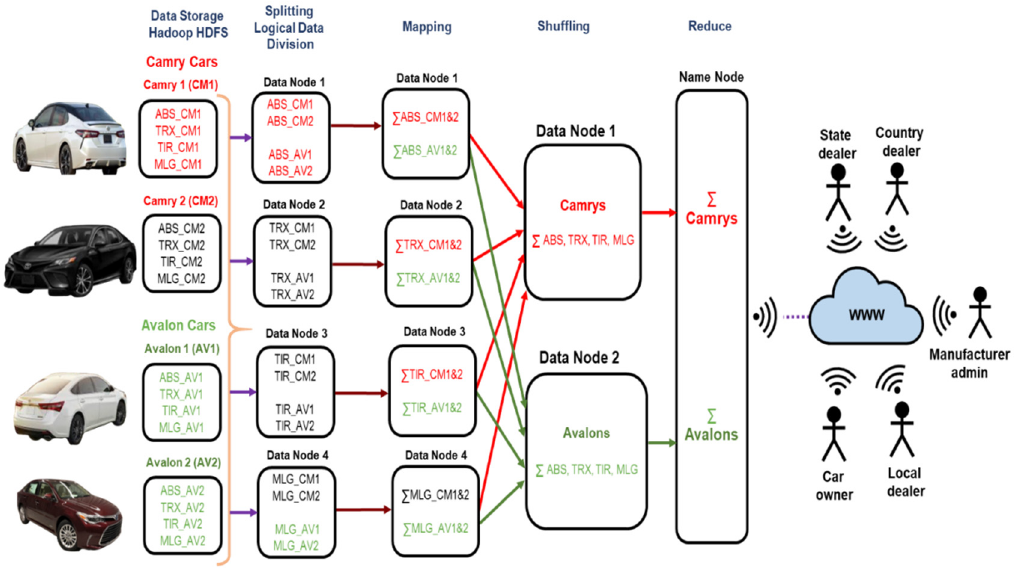
Figure 4. Use-case analytics’ model for vehicular digital twin in DAVL.